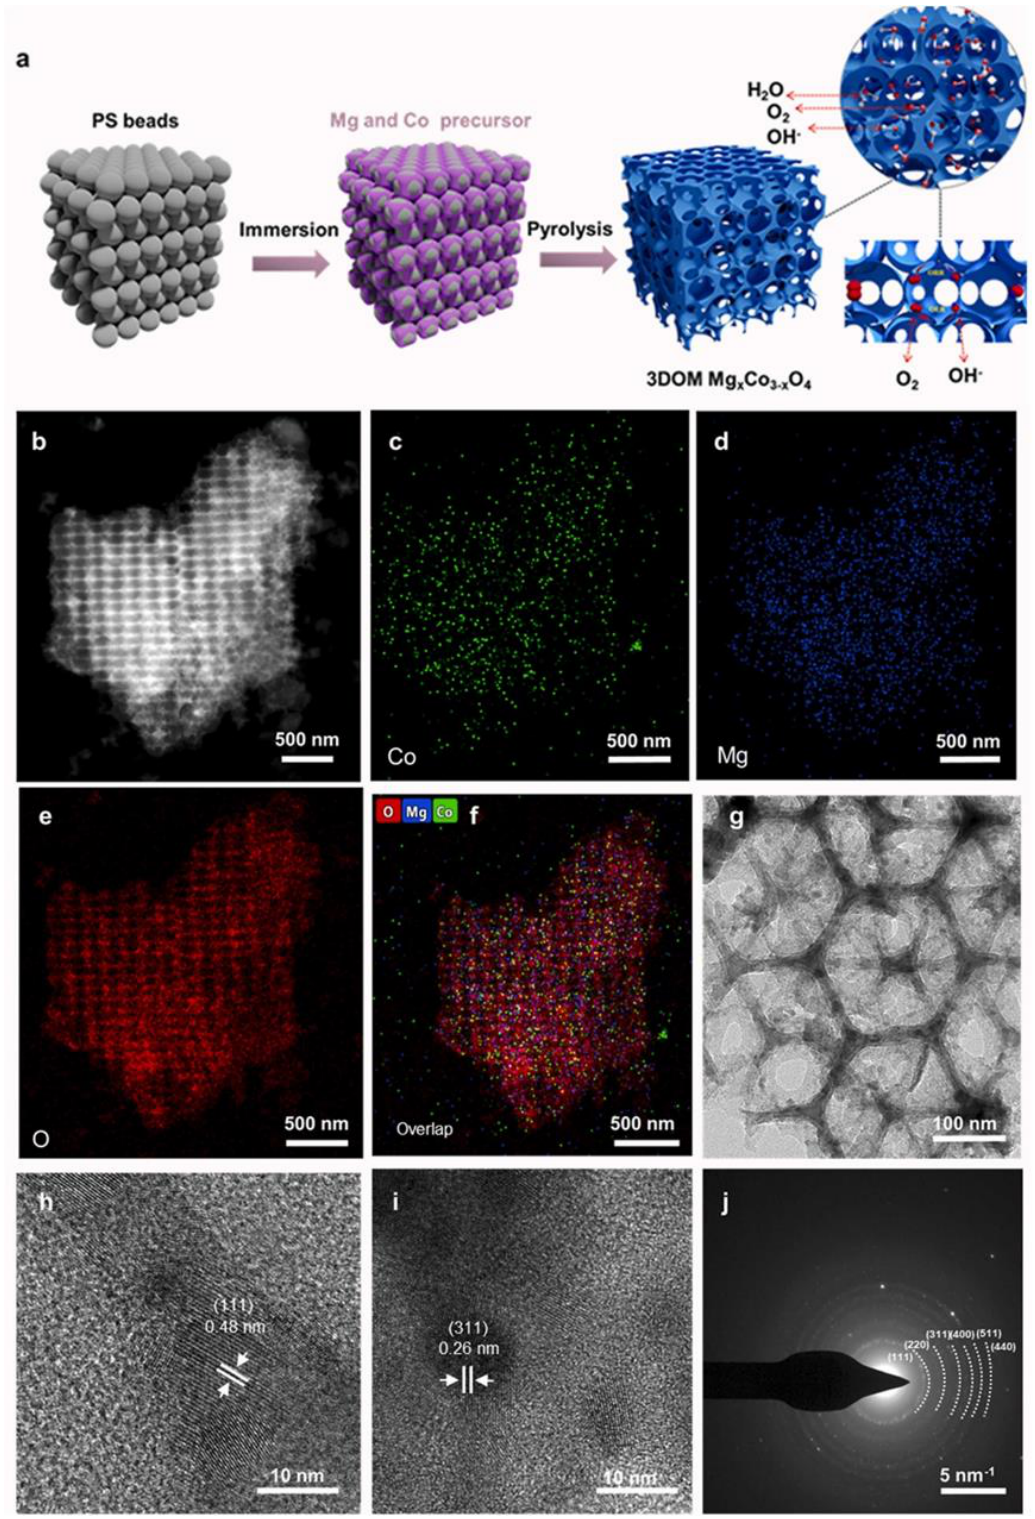
Figure 22. ( a ) Schematic illustration of the preparation procedure of 3DOM Mg x Co 3−x O 4 . ( b ) STEM image, ( c – f ) corresponding EDS elemental mapping, ( g – i ) TEM and HRTEM images, and ( j ) corresponding SAED pattern of 3DOM Mg x Co 3−x O 4 . (Reprinted with permission from [289]. Copyright 2022, Elsevier).